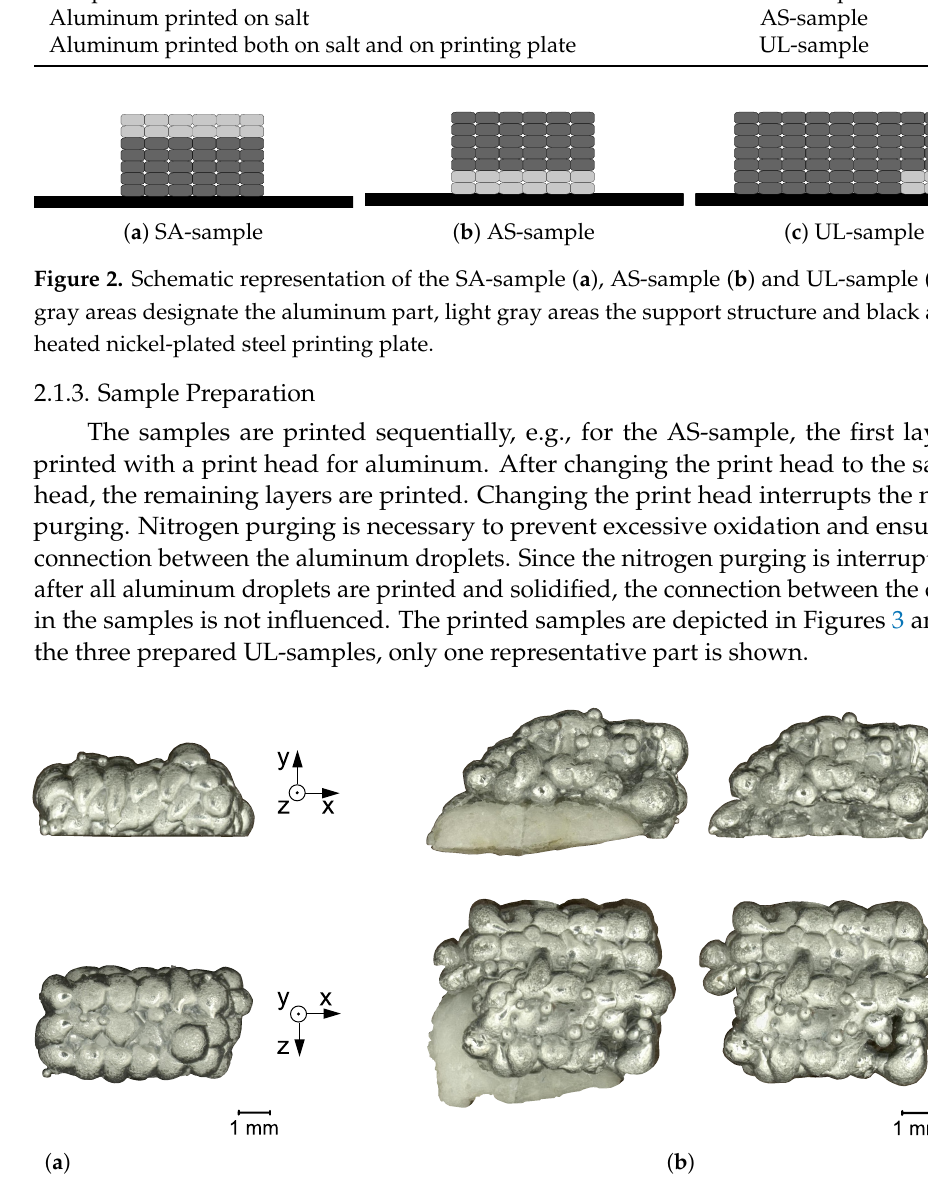
Figure 3. SA-sample ( a ) and AS-sample ( b ) with salt support structure and after support removal. The top row shows the samples viewed from the side, the bottom row viewed from